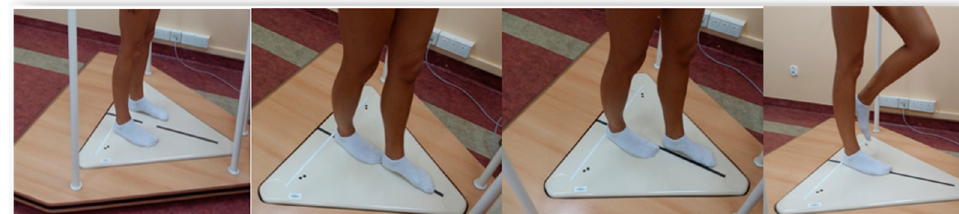
Figure 2. Testing procedure (from the left side): normal standing position, tandem position, semi- tandem position, one-leg standing position.